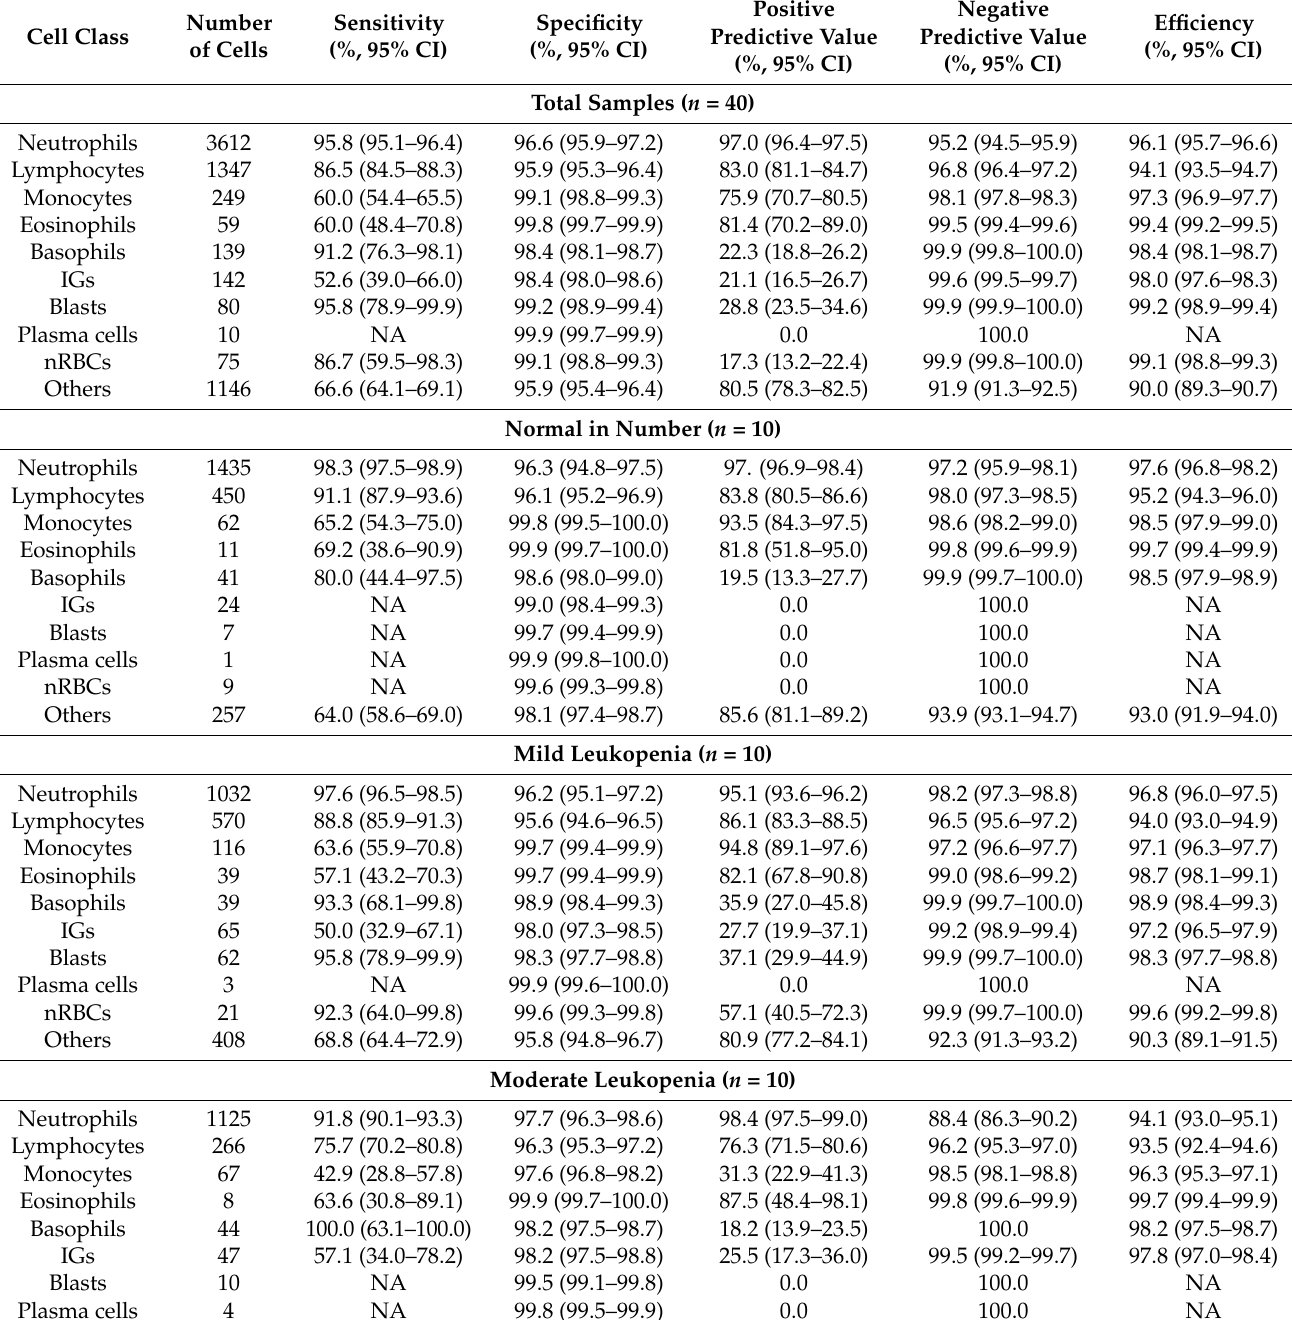
Table 3. Performance of WBC preclassification by DI-60 on the basis of